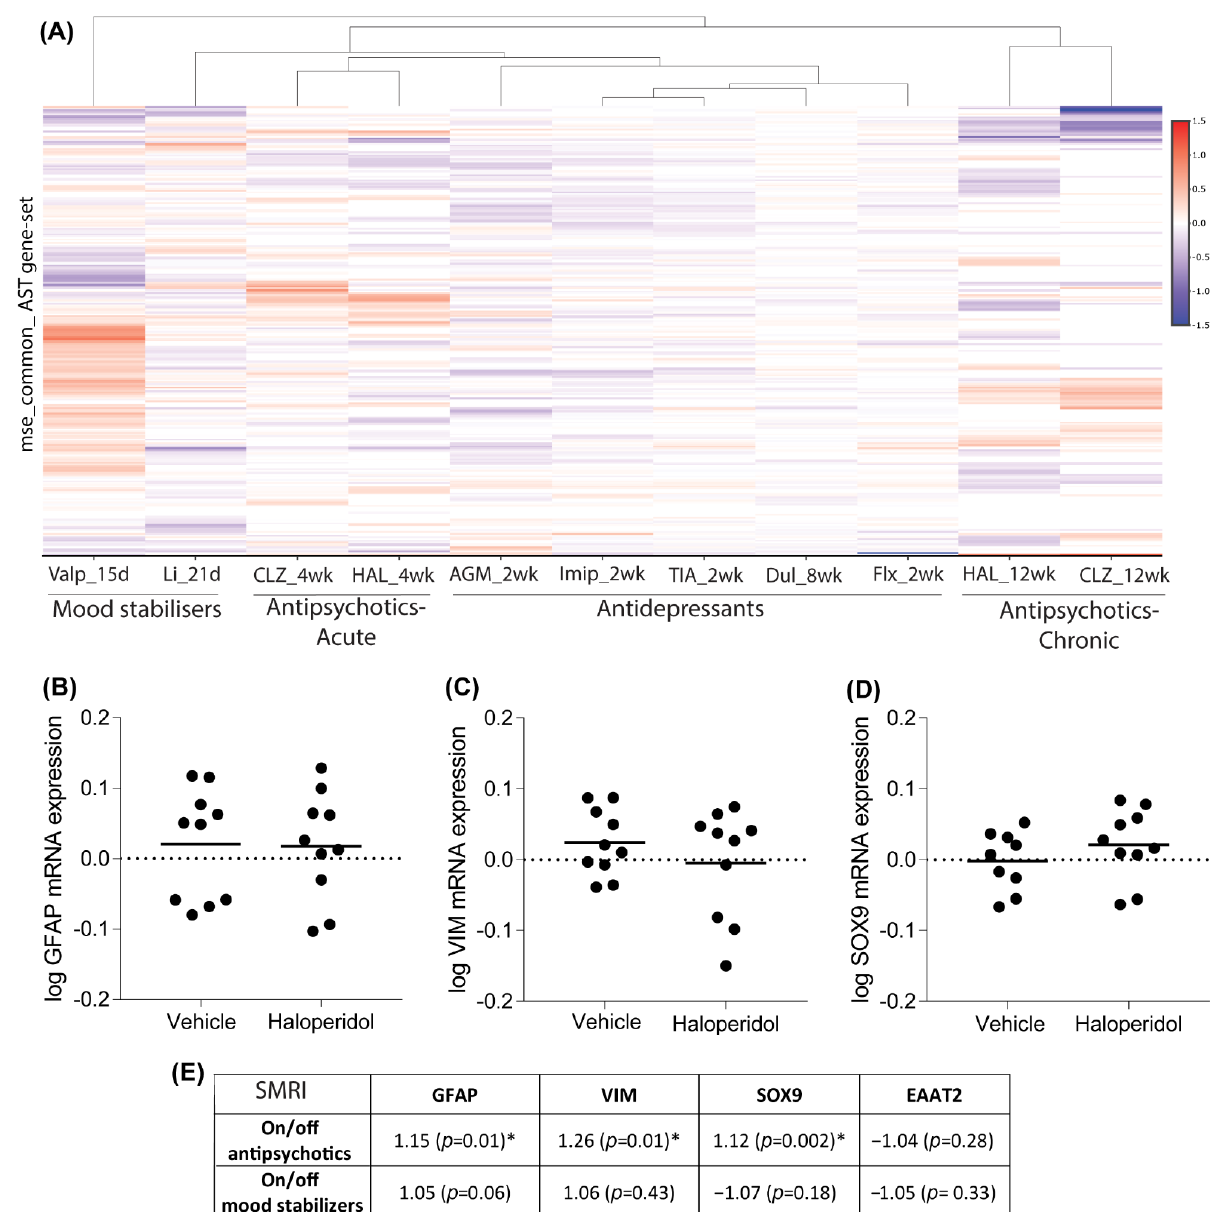
Figure 4. ( A ) Heatmap of log 2 fold change transcript expression of astrocyte marker gene list, derived from mouse_common gene-set, in models of psychotropic drug administration. Differences in patterns of gene expression were identified in 12 weeks compared to 4 weeks of antipsychotic administration. In rats treated for 36 weeks (9 months) with the antipsychotic haloperidol-decanoate ( n = 10/group), frontal cortex mRNA expression of astrocyte markers ( B – D ) GFAP, VIM, and SOX9 was not significantly different (Student’s t -test, p > 0.05) compared to vehicle treated control ( n = 10/group). ( E ) Descriptive statistics of gene expression of GFAP, VIM, and SOX9 in the chronic antipsychotic-treated rat study. Data was log-transformed. Data expressed as mean. GFAP glial fibrillary acidic protein, VIM vimentin, SOX9 SRY (sex-determining region Y)-box 9. * p < 0.05. 3.5. Exploratory Studies of Common Protein Kinase Activity Profiles in Postmortem Glial